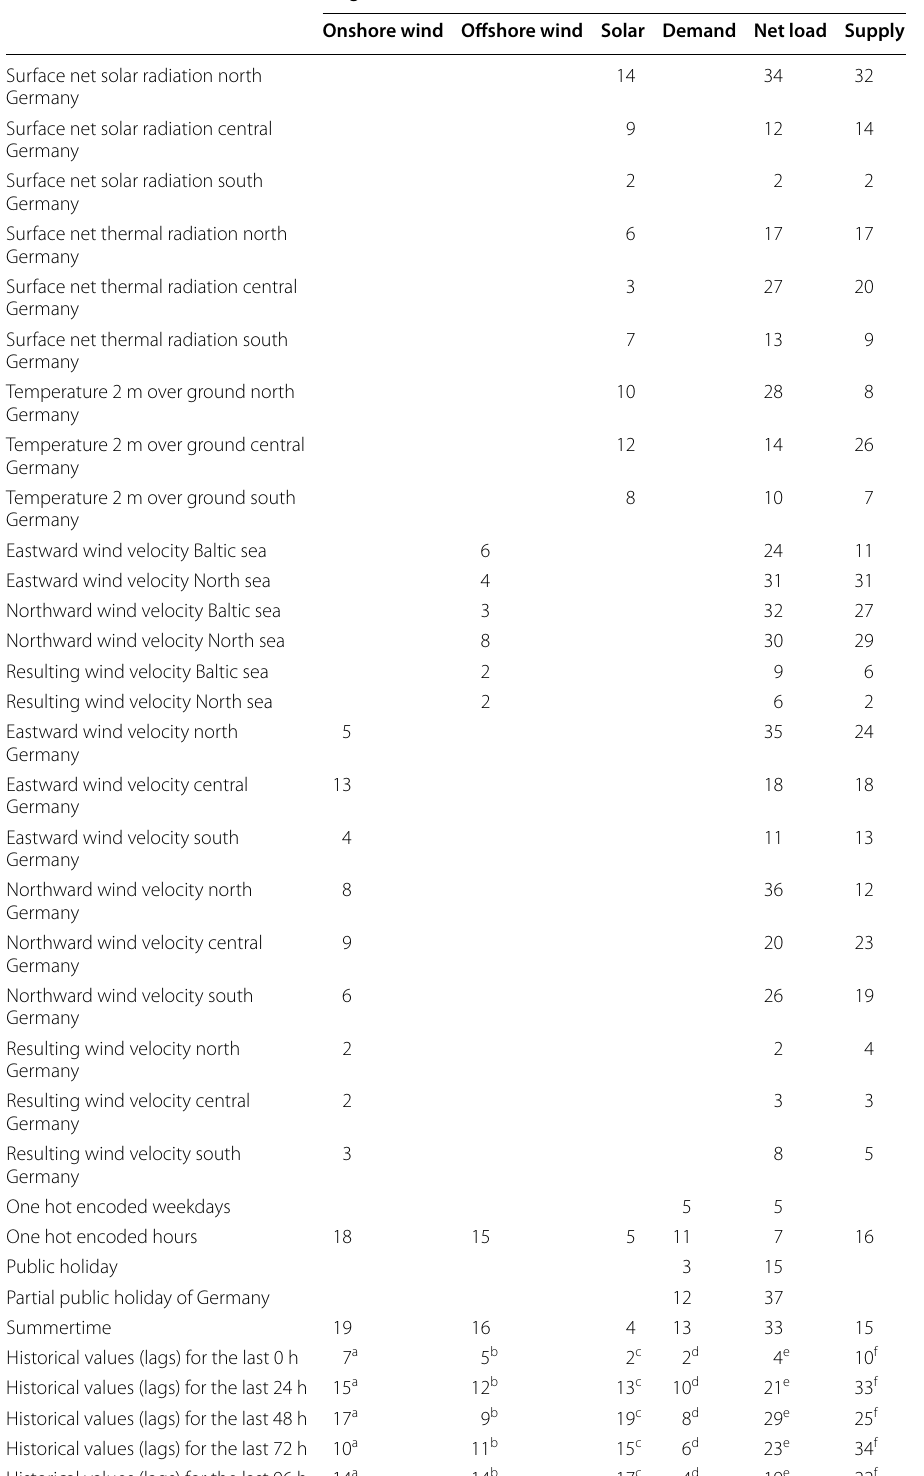
Table 1 An overview of the progressive feature selection for each target time series Target time series to be